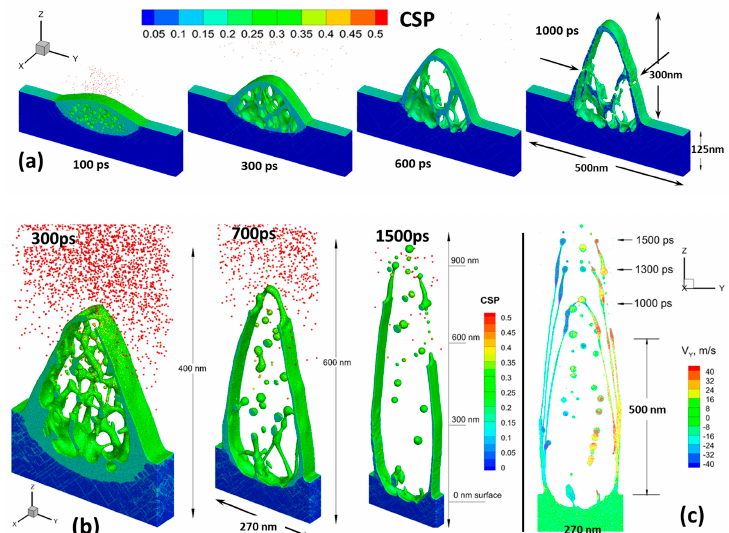
Figure 4. ( a ) Sequence of atomistic snapshot configurations (100 ps, 300 ps, 600 ps, and 1000 ps) of a 500 - nm period structures obtained at the incident fluence of 160 mJ/cm 2 . The arrows on the 1000 ps snapshot indicates the formation of a crack along the nanostructure direction X. ( b ) Calculated shapes for 300 ps, 700 ps, 1.5 ns after the pulse for a 270-nm period structure obtained at an incident fluence of 250 mJ/cm 2 . The atoms are colored by CSP for distinguishing a local crystal structure as follows: crystal < 0.08 < defects (dislocations) < 0.11 < liquid < 0.25 < surfaces < 0.50 < vapor (free atoms). ( c ) The tangential (perpendicular to the incident pulse) Y component of the velocity field of the growing structure in ( b ) is shown by color for the set of times: 1000 ps, 1300 ps, and 1500 ps. It can be clearly seen that in the non-damaged parts of the surface (more precisely: in the areas where the fluence is below the threshold) the original morphology remains intact even at the highest fluence for the case of a 500-nm period (Figure 4a). However, as the incident fluence increases (Figure 3a), or at a smaller structure period of 270 nm, this non-influenced zone becomes very narrow. This is observed in Figure 4b, where the high incident fluence of 250 mJ/cm 2 results in an active formation of subsurface voids that develop fast and open to the surface by the time of 700 ps. While the non- influenced zone is getting narrow, the walls of neighboring grooves will collide and form one merged wall (nanoridge), as it experimentally can be seen in Figure 2c. This can also be concluded from Figure 4c, where the tangential component of the local velocities of the material in Y direction is plotted as a color field. Specifically, at the moment of the separation of the left and right wings of the growing